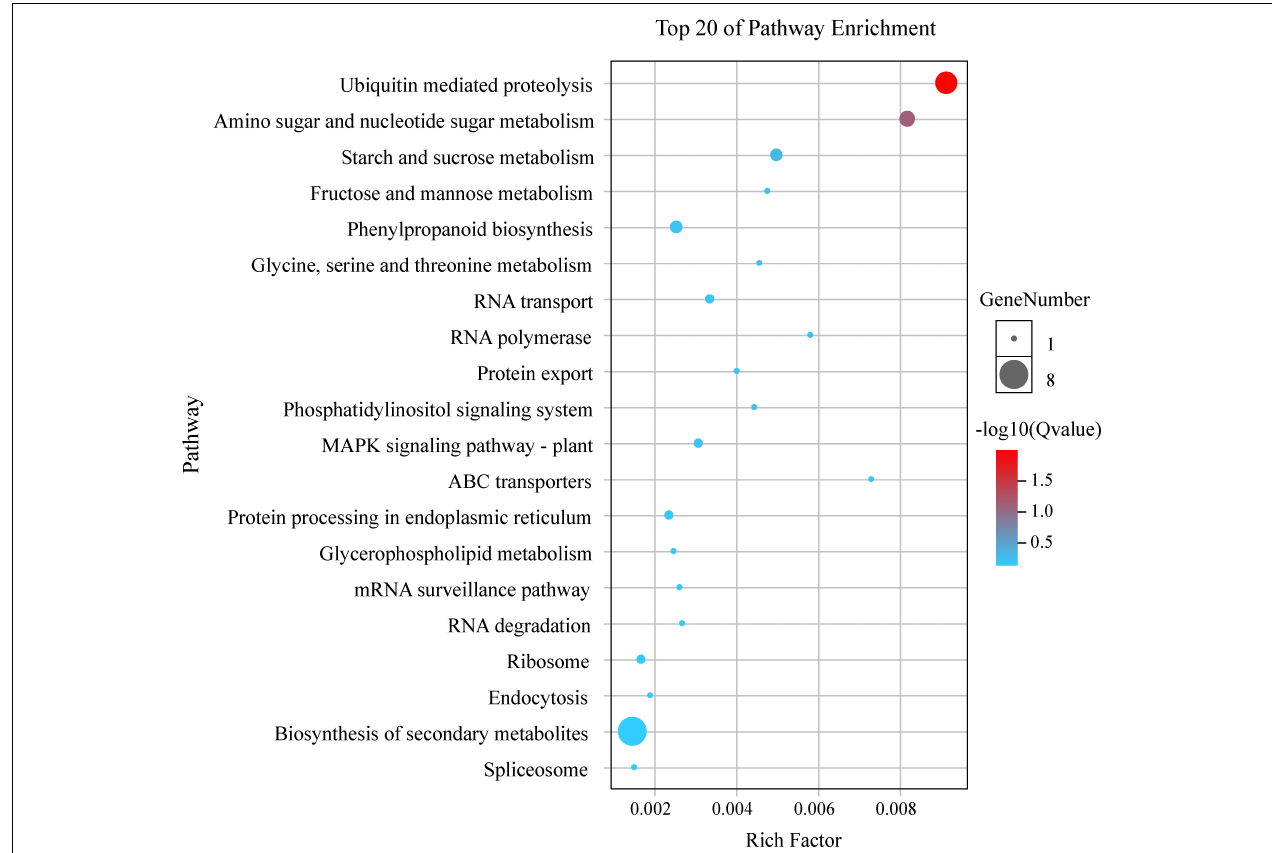
FIGURE 7 | Top 20 KEGG enrichment pathways for 134 putative candidate genes from MQTL